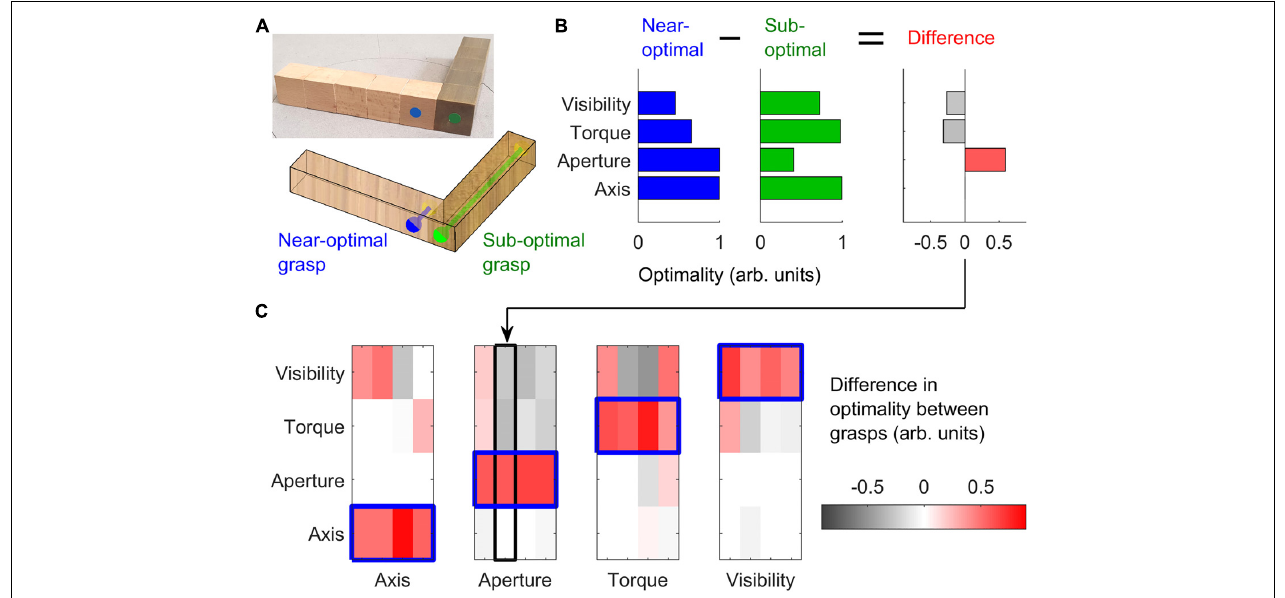
FIGURE 2 | Stimulus selection. (A) One example object in which we selected one optimal (blue) and one sub-optimal (green) grasp with respect to grasp aperture. The right side of the object is made of brass, the left side of beech wood. Blue and green dots represent thumb contact locations; the index finger is to be placed on the opposing surface. The blue grasp requires a small (2.5 cm) grip aperture, and is thus optimal with respect to grasp aperture. The green grasp requires a large grip aperture (12.5 cm) and is thus sub-optimal. (B) For the two selected grasps in panel (A) , we plot the optimality of the grasps (in normalized, arbitrary units) for each of the 4 optimality criteria, and the difference in optimality between grasps. (C) The difference in grasp optimality is shown for all pairs of grasps selected on all 16 objects, 4 per optimality criteria. Red indicates the selected near-optimal grasp is better than the selected sub-optimal grasp. Each column corresponds to one of the 16 objects employed in the study. The object and grasps in panel (A) correspond to the second column of the Aperture subplot in panel (C) .